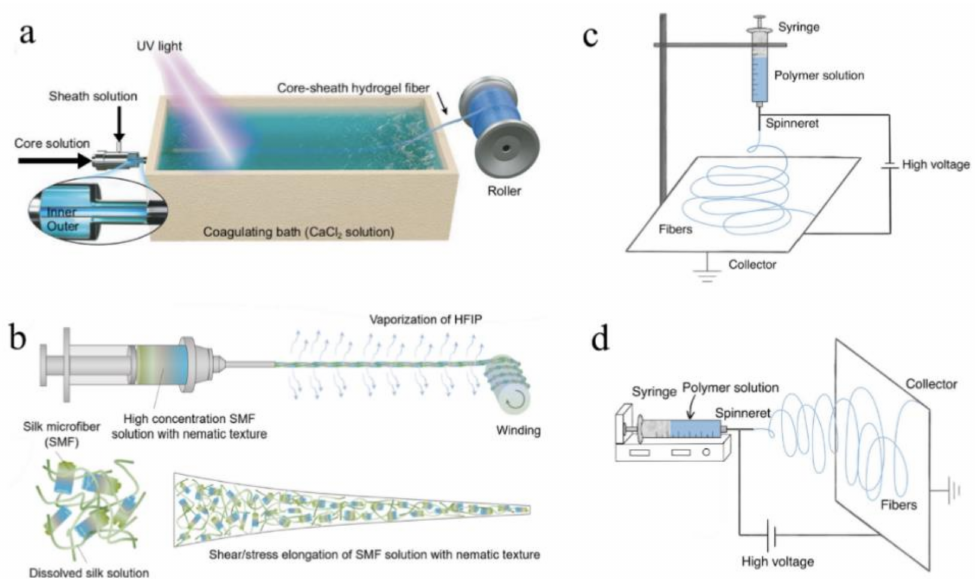
Figure 6. A schematic showing the ( a ) ILDAWS process. (Reprinted with permission from ref. [88]). ( b ) Bioinspired dry spinning process. (Reprinted with permission from ref. [140]). ( c ) Vertical electrospinning setup device. (Adapted from ref. [148]). ( d ) Horizontal electrospinning setup device. (Adapted from ref.